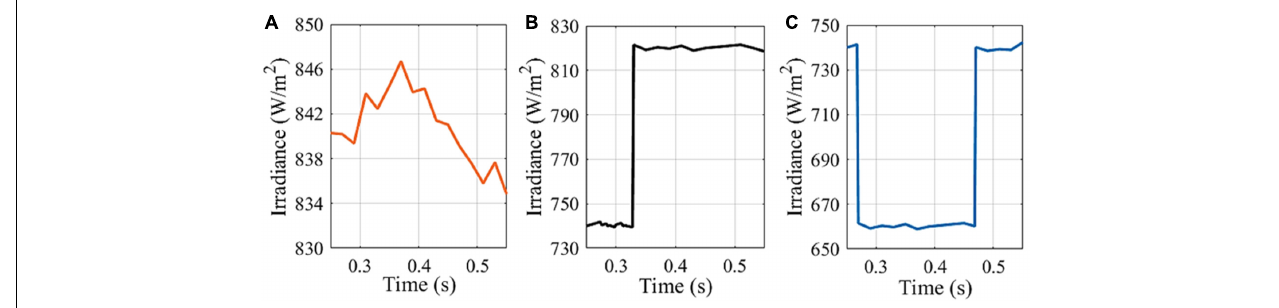
FIGURE 7 | Examples of irradiance input data in three test scenarios: (A) Case I, (B) Case II, (C) Case III.